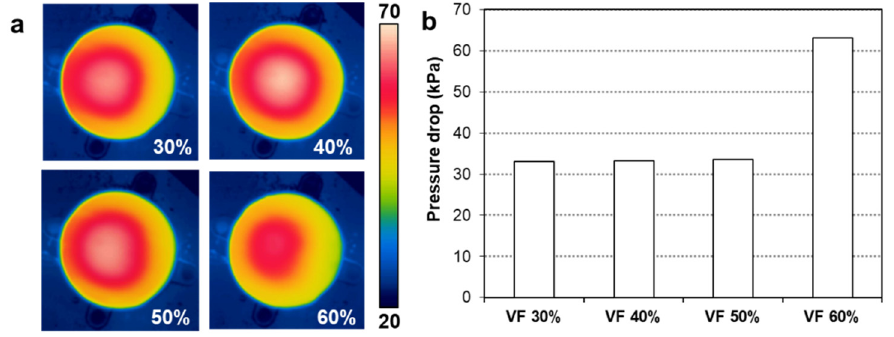
Figure 11. Results of heating experiments with various volume fractions: ( a ) Temperature distribu-